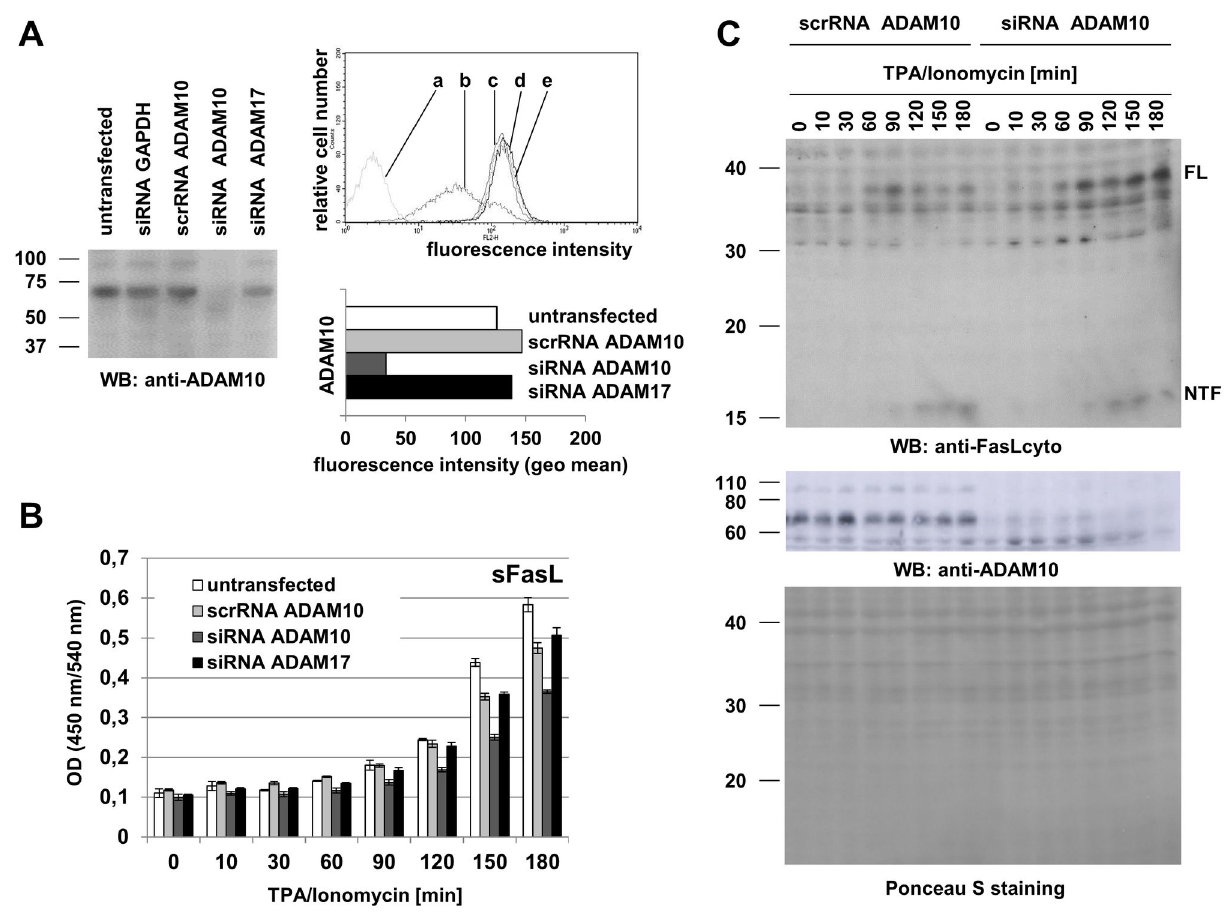
Figure 5. Knockdown of ADAM10 by siRNA blocks the production of sFasL. A. The efficacy of the ADAM10 knockdown was monitored by Western blotting of whole cell lysates from untransfected or siRNA-transfected PHA blasts (left panel). Here, the level of surface ADAM10 was significantly reduced in ADAM10 siRNA-treated cells but not in the respective controls. Moreover, surface ADAM10 was analyzed by flow cytometry using a respective isotype control (light grey line, a) and mAb AD214Y. ADAM10 expression was only reduced in ADAM10 siRNA-treated cells (black dotted line, b), but not in untransfected (dark grey line, c), control siRNA- (black line, d) or ADAM17 siRNA-treated (dashed dark grey line, e) PHA blasts (upper right panel). Data in the bar graph (lower right panel) represent geometric mean values calculated from the individual histograms. B. In addition, culture supernatants collected at the indicated time points were tested for the presence of soluble FasL by ELISA. As expected, sFasL production was most prominently affected in ADAM10 siRNA-treated cells. C. In order to analyze the presence of full length (FL) FasL and its N-terminal fragments (NTF), scrRNA- and ADAM10 siRNA-transfected T cell blasts were lysed at the indicated time points after stimulation with TPA and Ionomycin. FasL was detected using a mAb (FasLcyto2) generated in our laboratory against the intracellular region of the molecule and thus allowing the simultaneous detection of full length FasL (FL) and proteolytically generated N-terminal fragments (NTF) (upper panel). The ADAM10 knockdown was monitored by reprobing the blot with a polyclonal anti-ADAM10 antibody (middle panel). Equal protein loading and transfer was routinely checked by Ponceau S staining (lower panel). doi: 10.1371/journal.pone.0076853.g005 cells, and no significant change in the Hodgkin’s lymphoma cell ADAM proteases are supposed to be translated as inactive line L248, HeLa cells, U266B1 myeloma cells, Panc89 or pro-enzymes, containing a pro-domain that works as an Jurkat variants. Comparing the calculated geometric mean intramolecular chaperone, keeping the protease in an inactive values, one should stress that also the levels of ADAM17 detected after stimulation remain minute when compared to the domains are believed to be cleaved off by furin or pro-protein level of ADAM10. convertases. The exact mechanisms how ADAM10 and 17 are stored, activated or transported to the plasma membrane,